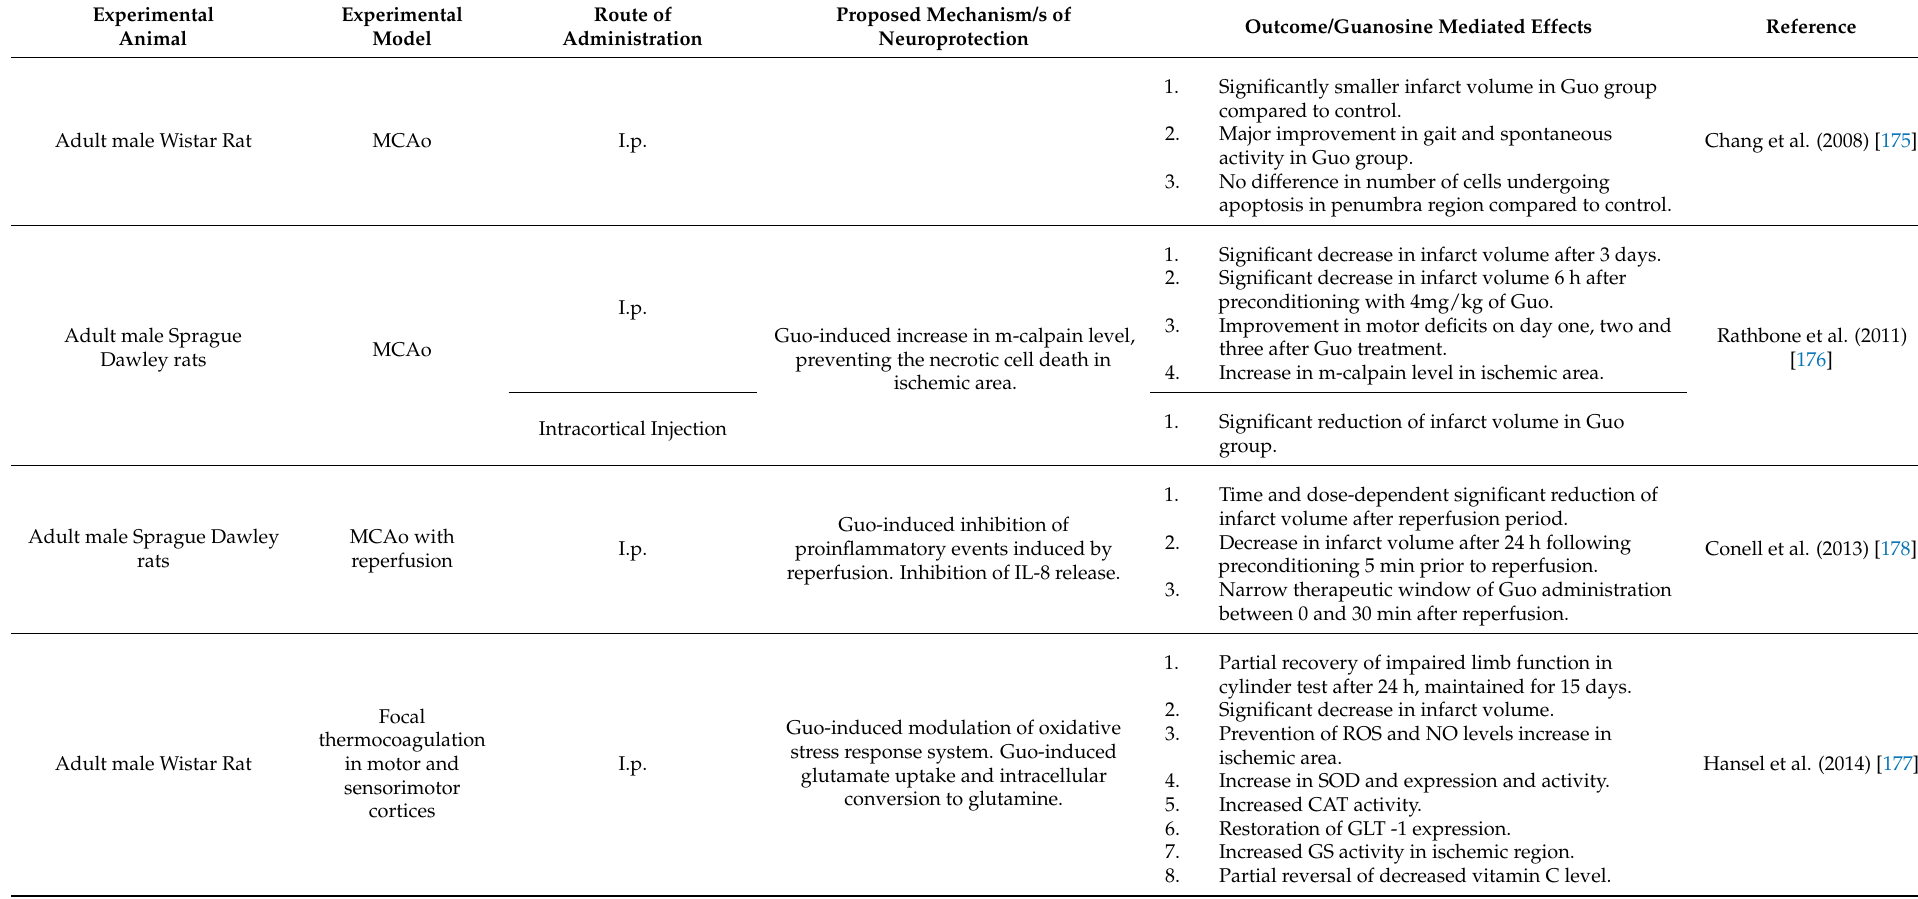
Table 1. The comparison of in vivo studies evaluating the neuroprotective effects of guanosine in ischemic stroke models focused on proposed molecular mechanisms and final outcomes. Experimental